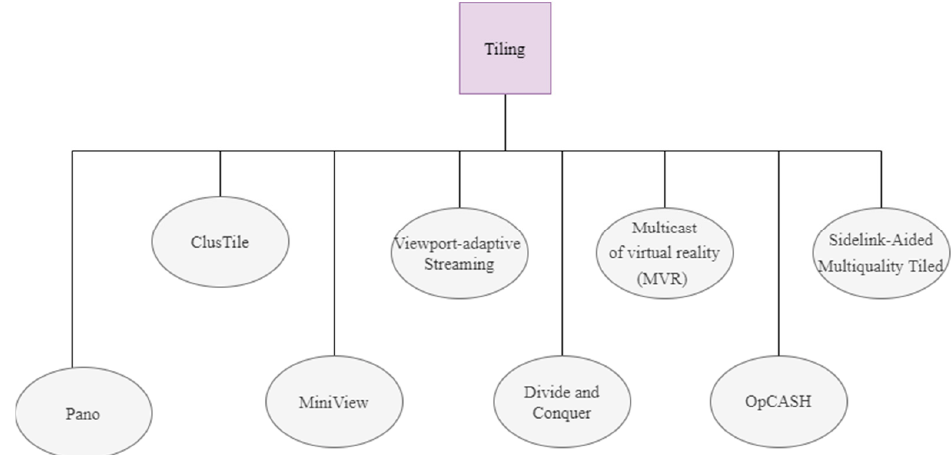
Figure 7. Methods using the tiling technique.